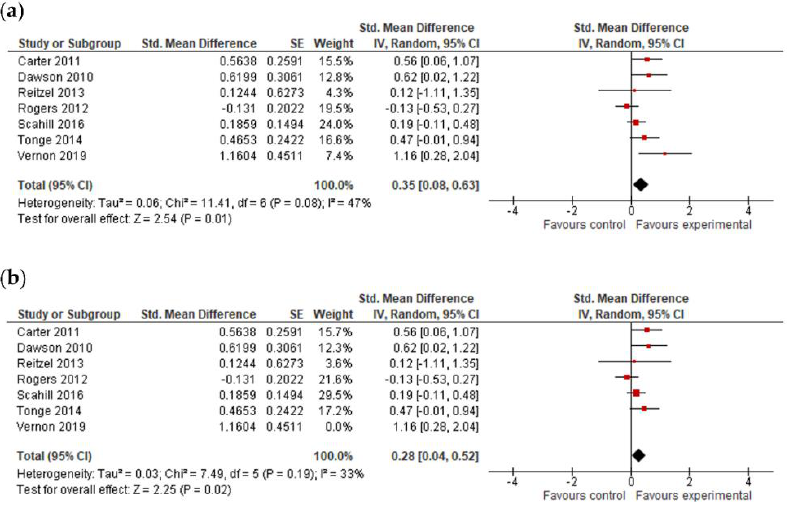
Figure 9. Forest plots for daily living skills. ( a ) Overall effect [29,30,45,48,50,55,58]. ( b ) Results after exclusion of studies with no blinding of outcome assessment [29,30,45,48,50,55].